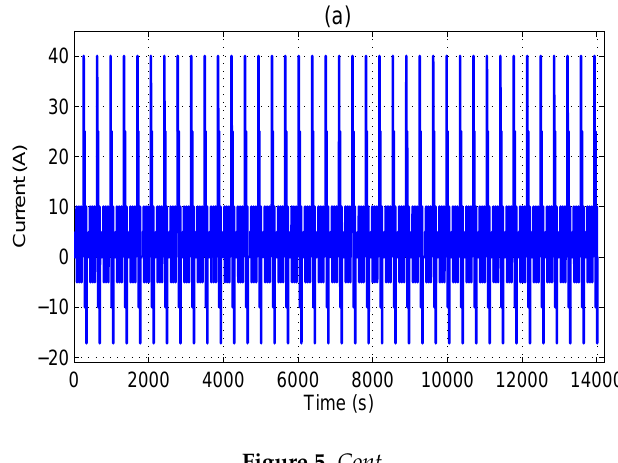
Figure 5. Cont. Figure 5. Cont